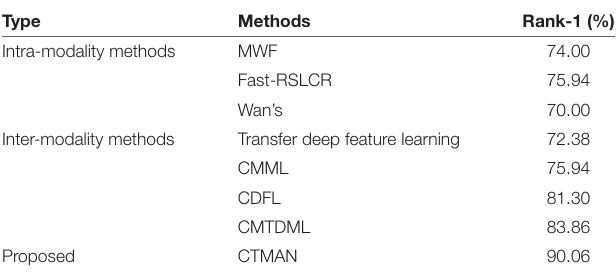
TABLE 7 | Comparison experiment results on the S3 setup.